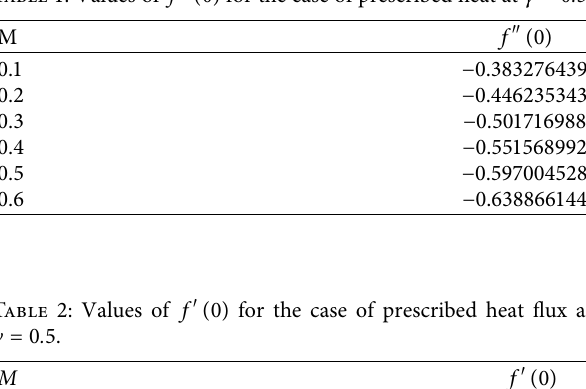
Figure 2: Profiles of f ′ ( η ) for the case of prescribed heat flux at c � 0 . 5. Table 1: Values of f ″ ( 0 ) for the case of prescribed heat at c � 0 . 5.